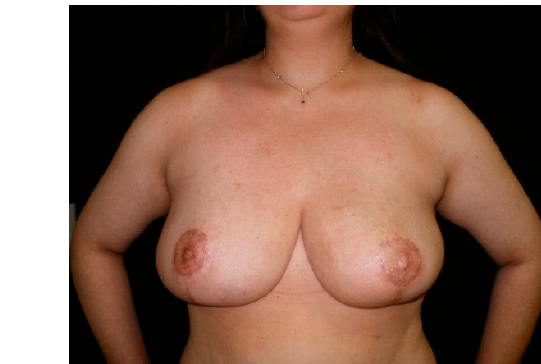
Figure 1. Pre- ( left side) and post-operative ( right side) images of a patient who had undergone a reduction mammoplasty of the irradiated tissue, with them having experienced a post-operative weight loss of nearly 30 kg.